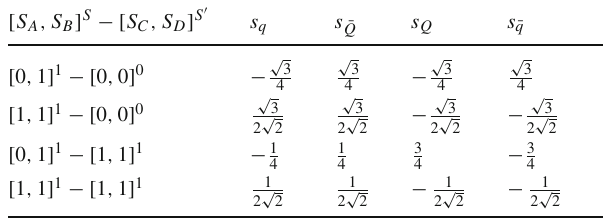
Table 5 (cid:6) [ χ C χ D ] S (cid:4) || s q || [ χ A χ B ] S (cid:7) in Eq. (17). S and S (cid:4) denote the total spin of the initial and final states, respectively